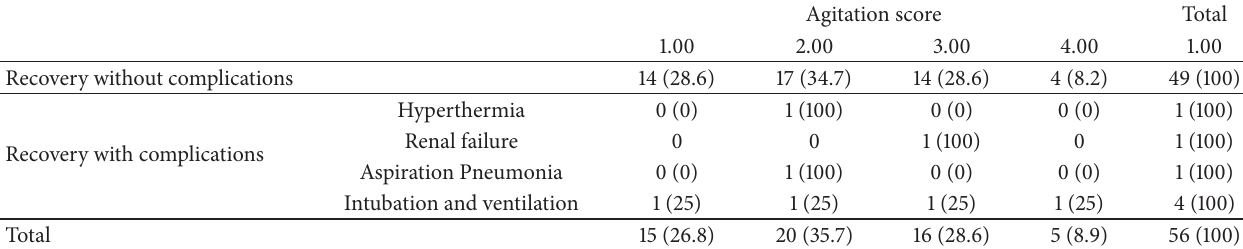
Table 4: Outcomes of therapy for study patients admitted with agitation regarding the agitation